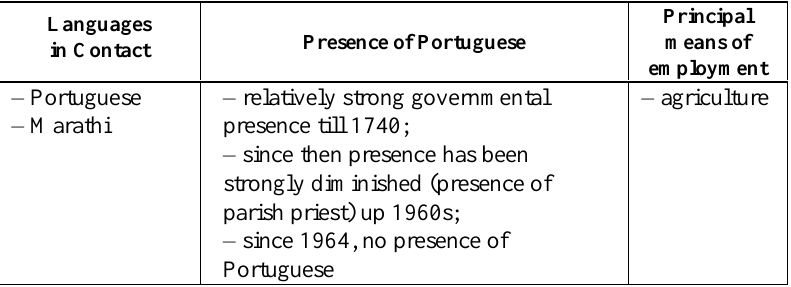
Table V. Information on the Korlai Christian community Languages